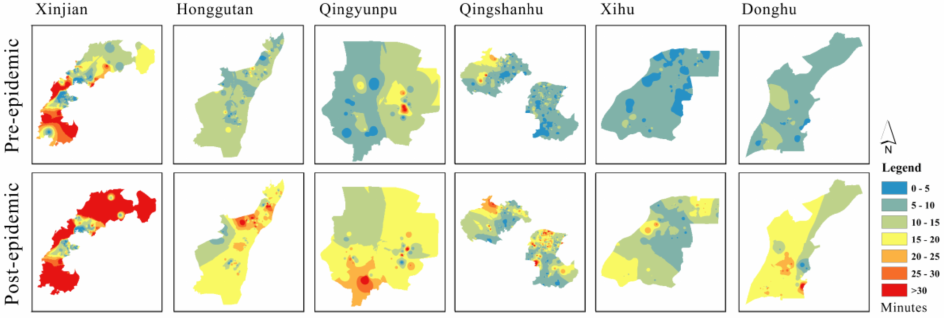
Figure 17. The walking accessibility under the high-risk